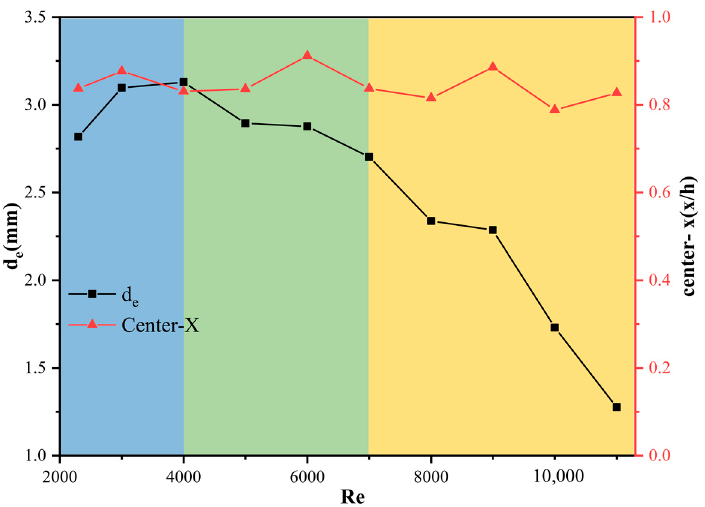
Figure 16. The position and size of the bubble changes.